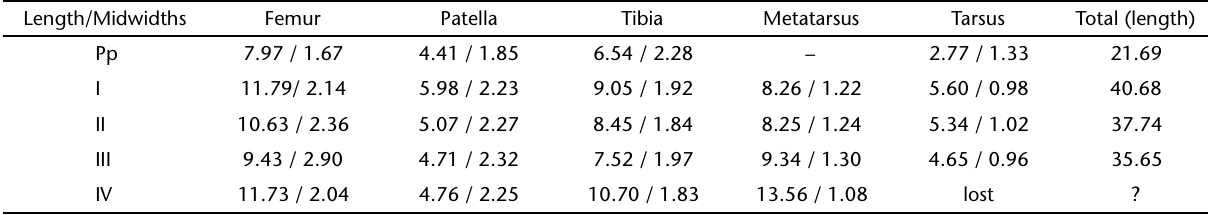
Table I. Vitalius nondescriptus comb. nov. Holotype male MNRJ 43 from Ouro Preto, state of Minas Gerais, Brazil. Length and midwidthsof right legs and palpal segments. Length/Midwidths